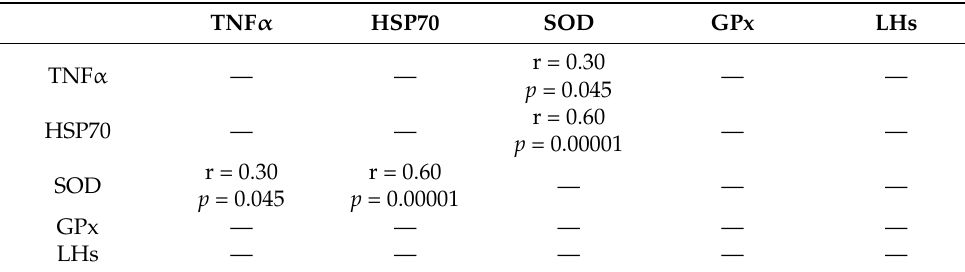
Table 6. Statistically significant correlations between biochemical parameters analysed prior to (pre) 12-week swimming training in the whole group of students ( n = 63). TNF α HSP70 SOD GPx LHs TNF α